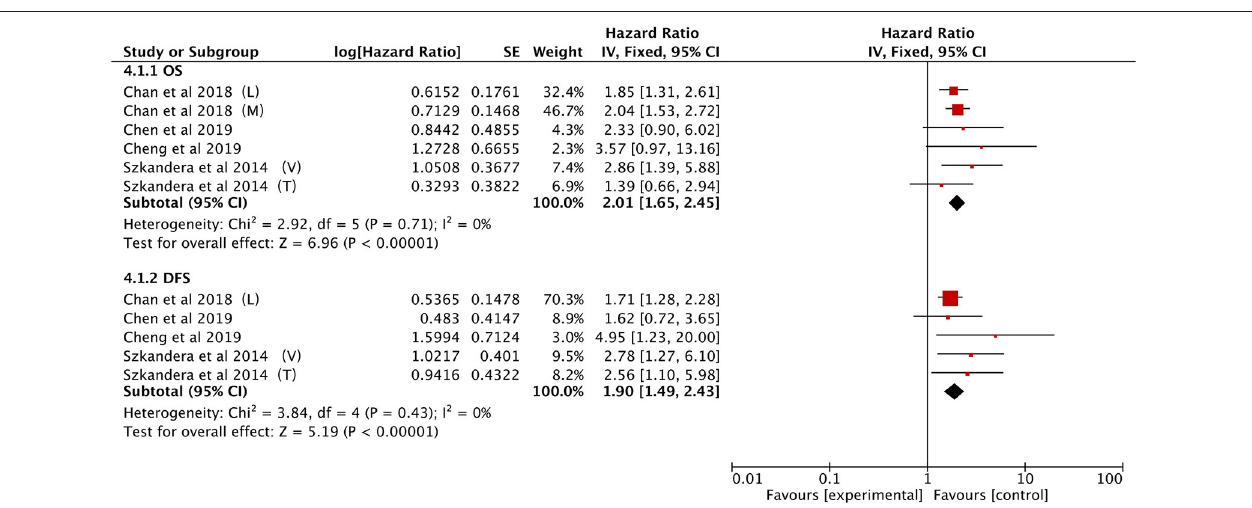
FIGURE 6 | Forest plots of the Prognostic effect of LMR for OS/DFS.